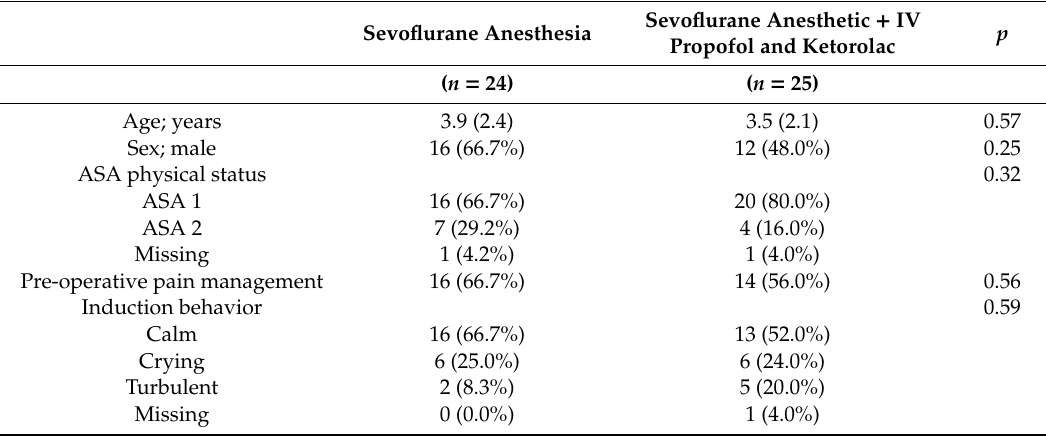
Table 2. Characteristics of patients having bilateral myringotomy and tympanostomy tube insertion organized by type of anesthetic provided. Values are mean (SD) or number (proportion).